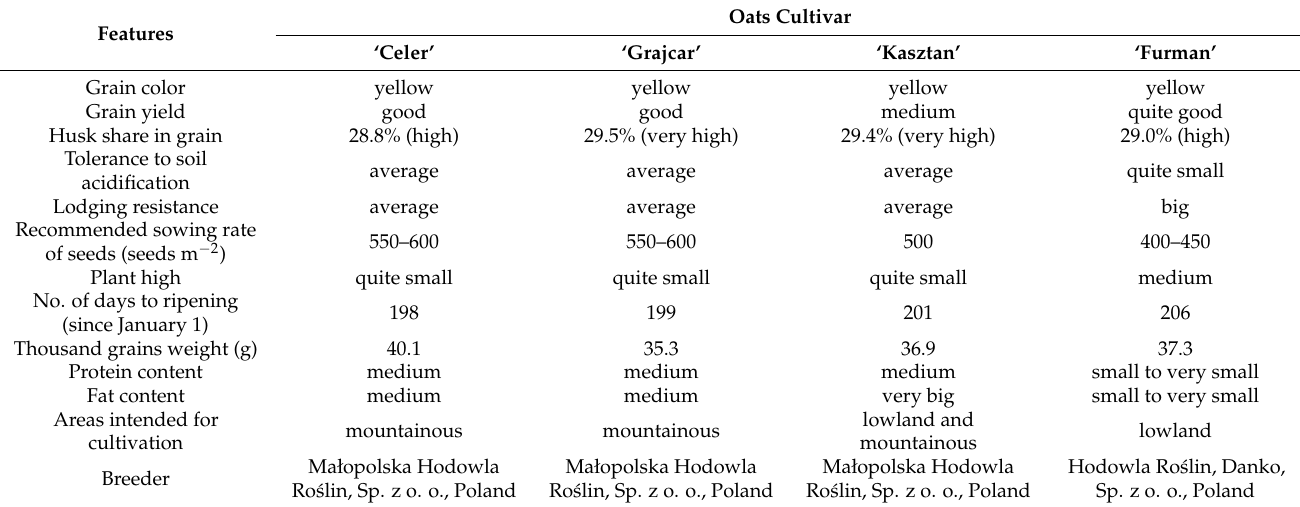
Table 2. Characteristics of oats’